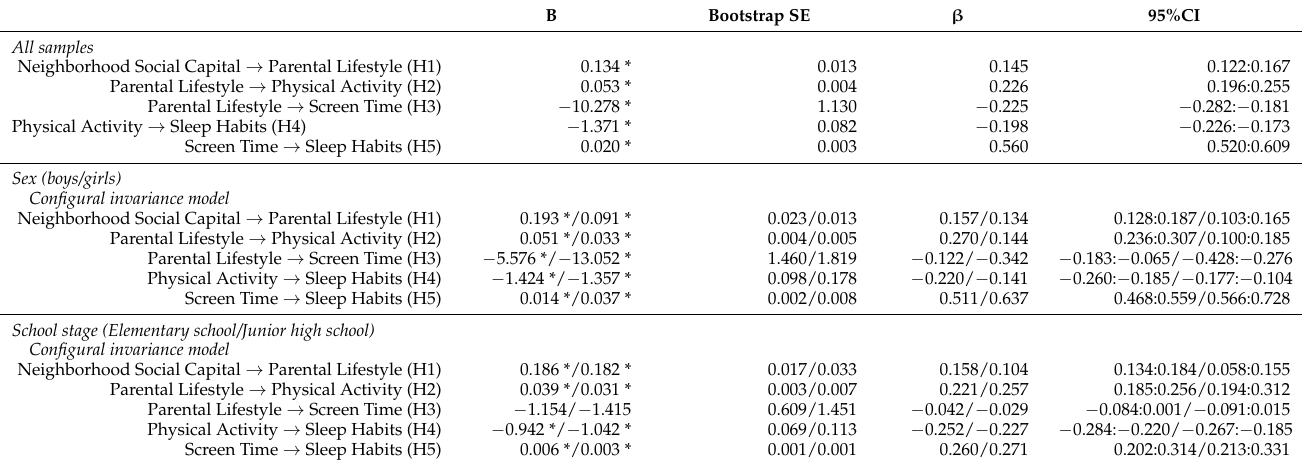
Table A1. The results of partial regression coefficient (B), Bootstrap SE, Standardized partial regression coefficient ( β ), and 95%CI by structural equation modeling using the bootstrap